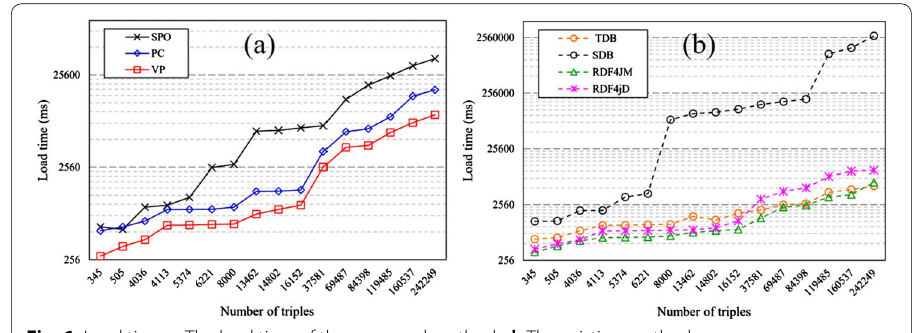
Fig. 6 Load time. a The load time of the proposed methods. b The existing